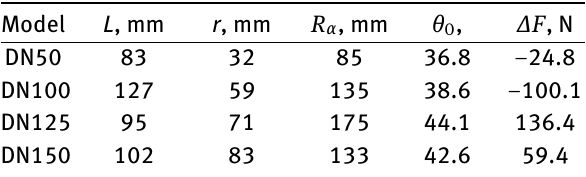
Table 4: Optimized parameters of rubber pipes.